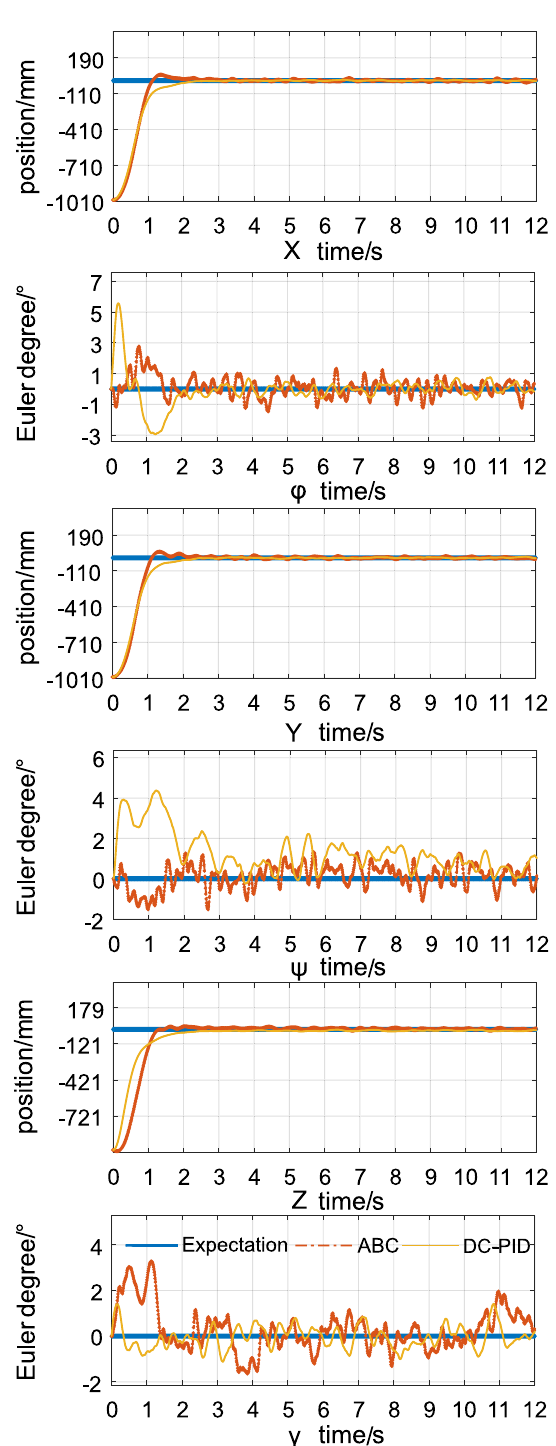
Figure 7. Errors in positions and attitudes for task 2.